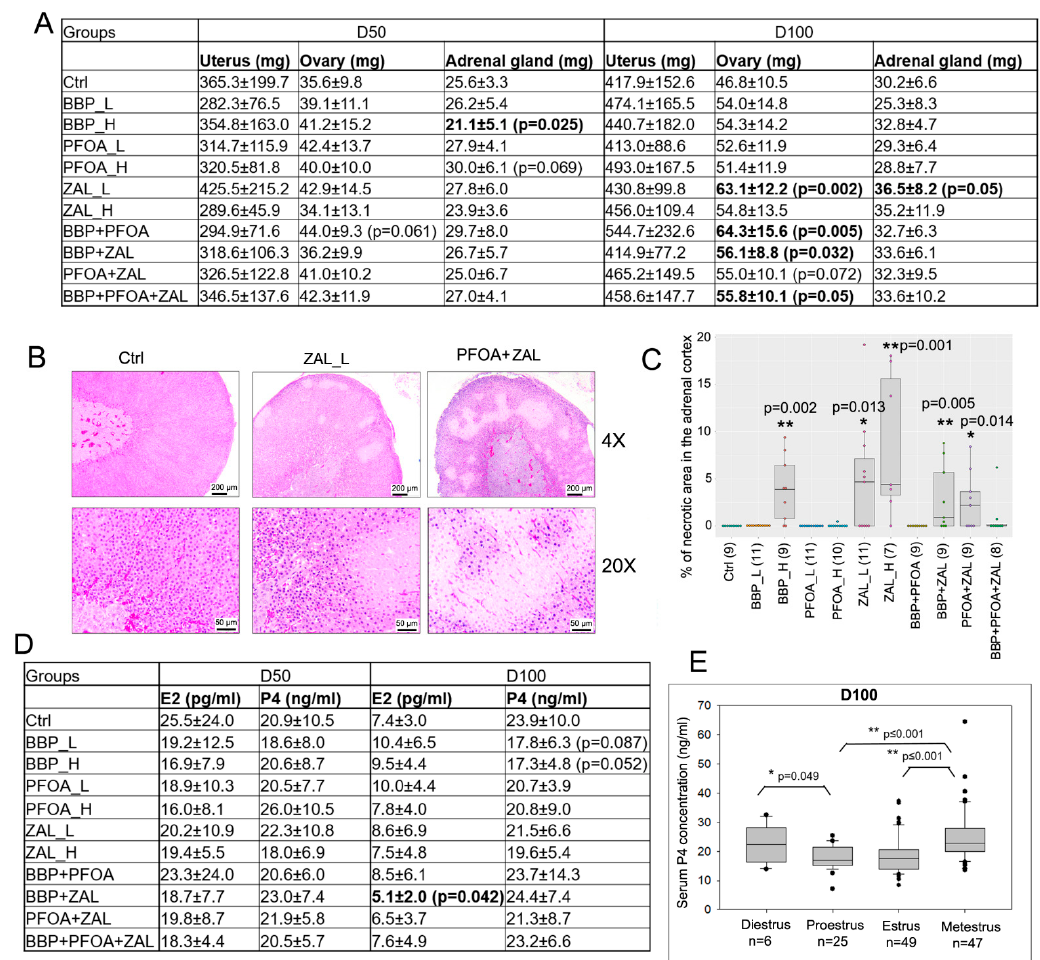
Figure 2. Changes in endocrine organs and serum hormones induced by exposure to BBP, PFOA, and ZAL: ( A ) Table shows the wet weight of uteri, ovaries, and adrenal glands at D50 and D100. The mean weight of two ovaries or adrenal glands of each rat was calculated and used to conduct the analysis. Sample size information is included in the Supplementary Materials. ( B ) Representative images of adrenal glands by H&E staining, showing necrosis in the adrenal cortex. Scale bar: 200 µm for 4×, 50 µm for 20× objective. ( C ) Quantification of the necrotic area in the adrenal gland cortex; each dot represents one rat. The samples with poor sectioning were excluded. ( D ) Serum E2 and P4 concentrations at D50 and D100; data are presented as the mean ± STD. ( E ) Association of serum P4 concentration with the phase of the estrous cycle. Only the samples that had enough cells for vaginal smear analysis were included. The Mann–Whitney rank sum test was used to perform the analysis; * indicates p < 0.05, ** indicates p < 0.01 compared to Ctrl for ( A , C , D ).